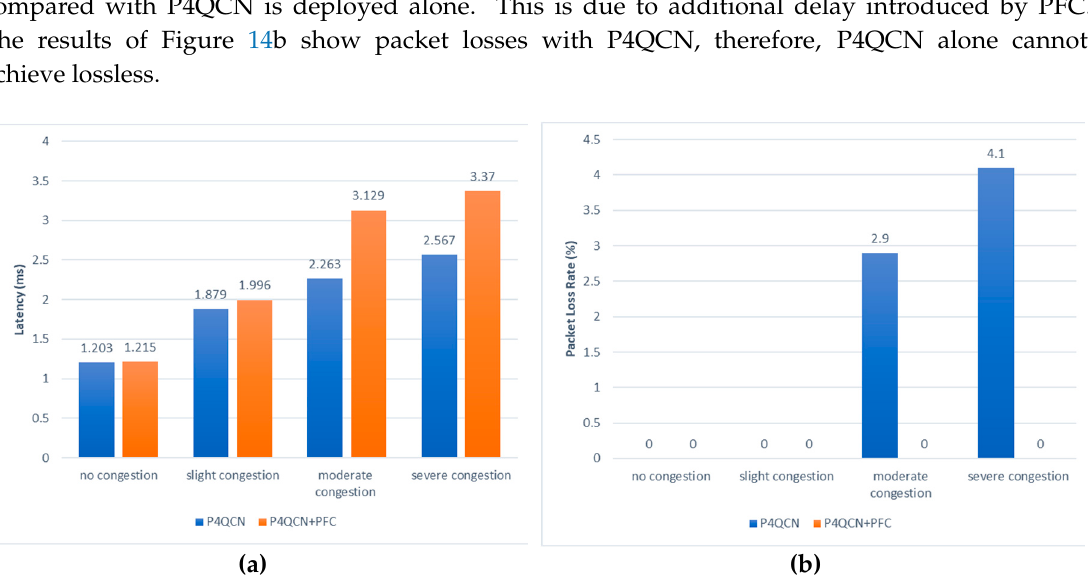
Figure 13. ( a ) Latency comparison of P4QCN, UDP and TCP; ( b ) Packet loss comparison of P4QCN and UDP.